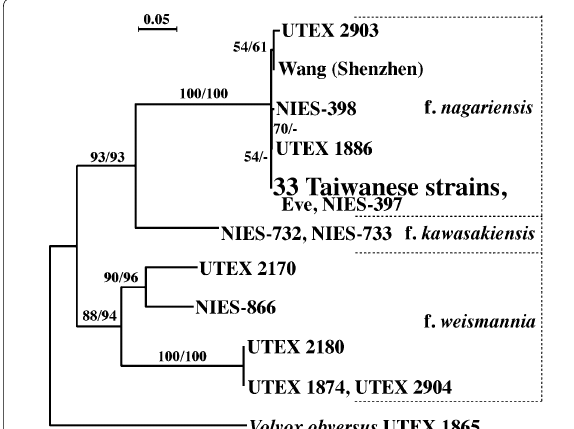
Fig. 3 Phylogenetic positions of 33 Taiwanese strains within three forms of Volvox carteri . The tree was based on the maximum likeli‑ hood (ML) analysis of the data matrix of Kawafune et al. (2015) plus a Chinese strain “Wang (Shenzhen)” (Additional file 1: Figure S1). Num‑ bers at left and right above the branches represent bootstrap values (50% or more) of ML and maximum parsimony analyses, respectively, based on 1000 replicates. The branch lengths are proportional to the evolutionary distances used in the ML analysis and indicated by bar above the tree. For details, see “Methods”